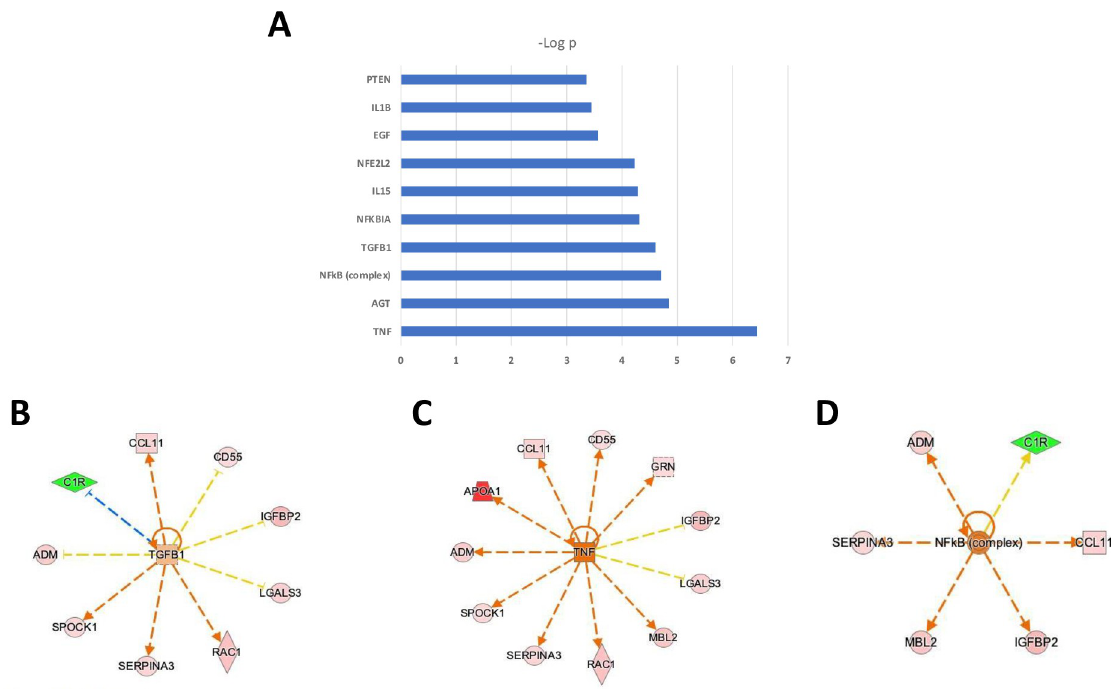
Fig 1. Principal component analysis of exosome proteins from patients with Raynaud’s Phenomenon with positive ANA compared to patients with Raynaud’s Phenomenon with negative ANA. Principal Component analysis of 22 differentially expressed proteins between samples of patients with Raynaud’s Phenomenon with negative ANA (green) and patients with Raynaud’s Phenomenon with a positive ANA (red).